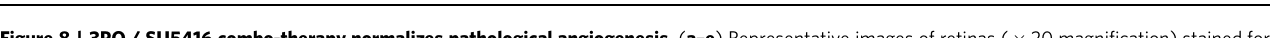
Figure 8 | 3PO / SU5416 combo-therapy normalizes pathological angiogenesis. ( a–e ) Representative images of retinas ( (cid:2) 20 magnification) stained for isolectinB4 (IB4) in normal conditions (nVEGF, a) and after VEGF injection (hVEGF, b-e). Pups were treated with DMSO (CTR, a , b ), 3PO ( c ), SU5416 ( d ) or 3PO plus SU5416 ( e ). Note the widened vessel lumen and fewer tip cells at the vascular forefront upon VEGF injection ( b ), and the partial ( c,d ) and complete ( e ) normalization by single or combined 3PO and SU5416 treatment. Scale bar, 50 m m. ( f,g ) Quantification of vessel width (f) and tip cell number at the retinal front (g). Data are mean ± s.e.m.; n ¼ 7 per condition; NS: not significant, * P o 0.05, *** P o 0.001 versus DMSO-treated vessels in normal conditions. ###, P o 0.001 versus DMSO-treated vessels in hVEGF. The statistical significance between the single or combined 3PO/SU5416 treatments is also indicated (NS: not significant, * P o 0.05, ** P o 0.01, *** P o 0.001); Student’s t -test. a.u., arbitrary units. ( h ) VE-cadherin junction classification from ‘active’ (red; irregular/serrated morphology with vesicular/diffuse regions) to ‘inhibited’ (dark blue; straighter morphology and less vesicular staining). ( i–p ) VE-cadherin morphology of retinal vessels was hand-classified according to the key in h, yielding VE-cadherin heat maps in normal conditions (nVEGF, i ) and upon VEGF injection (hVEGF, j – p ) of pups, treated with DMSO ( j,k ), 3PO ( l,m ), SU5416 ( n,o ), or 3PO plus SU5416 ( p ). The colour(s) provide insight into the extent of junctional heterogeneity of the vessels. Compared to the heterogeneous VE-cadherin pattern in nVEGF retinas ( i ), hVEGF induces clusters of inhibited ( j ) or activated ( k ) ECs. These clusters are smaller upon 3PO (inhibited: l ; active: m ) or SU5416 monotherapy (inhibited: n ; active: o ) and completely normalized to heterogeneous patterns upon combined 3PO plus SU5416 treatment ( p ). Scale bar, 20 m m. ( q,r ) Prevalence of strongly inhibited ( q ) or activated ( r ) VE-cadherin junctions in retinal vessels. Data are mean ± s.e.m.; n ¼ 5–9 per condition; NS, not significant, * P o 0.05, *** P o 0.001 versus nVEGF (black); # P o 0.05, ## P o 0.01 versus hVEGF (grey). The statistical significance between the single or combined 3PO/SU5416 treatments is also indicated (* P o 0.05); One-tailed Wilcoxon rank-sum test for equal